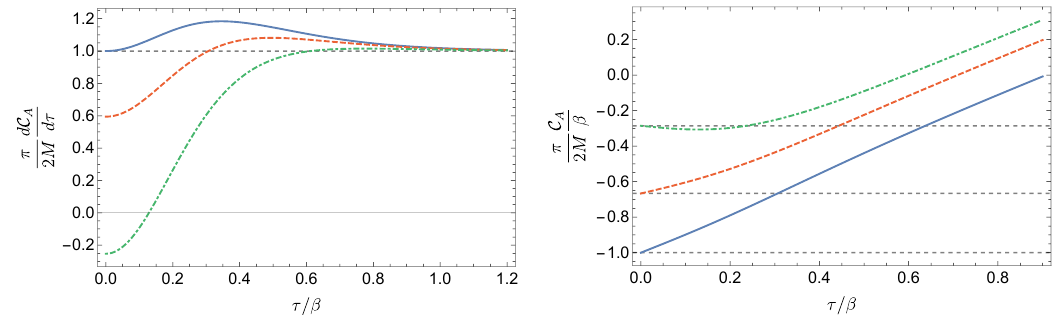
Figure 2 . Left panel: time derivative of the complexity for the BTZ black hole ( d = 2) from eq. (2.61) with (cid:11) = L=R . Right panel: ‘total’ complexity found by integrating d C A =d(cid:28) . Results are shown for several values of the horizon radius | r h =L = 1 (blue), r h =L = 1 : 5 (dashed red) and r h =L = 3 : 5 (dot-dashed